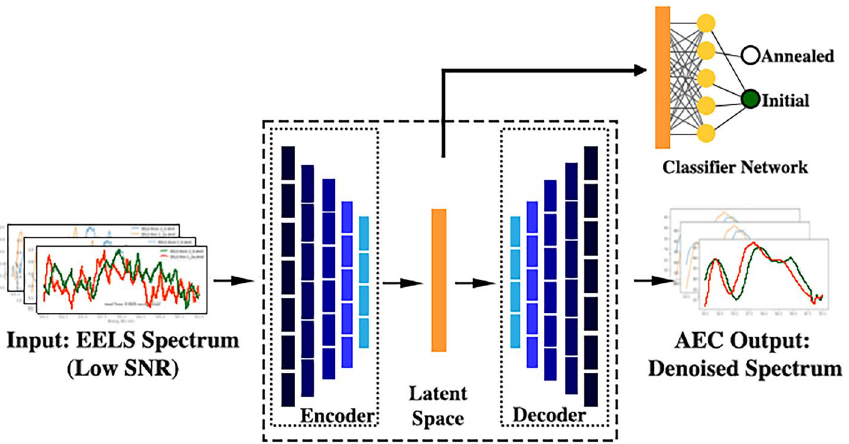
Figure 4. Visualization of the Neural Networks. The autoencoder learns a lower dimensional representation (latent space) of the input data and constructs denoised spectrum as output. The latent space representation of the ‘noisy’ spectrum is passed to the classifier, which determines if the input is initial or annealed state.